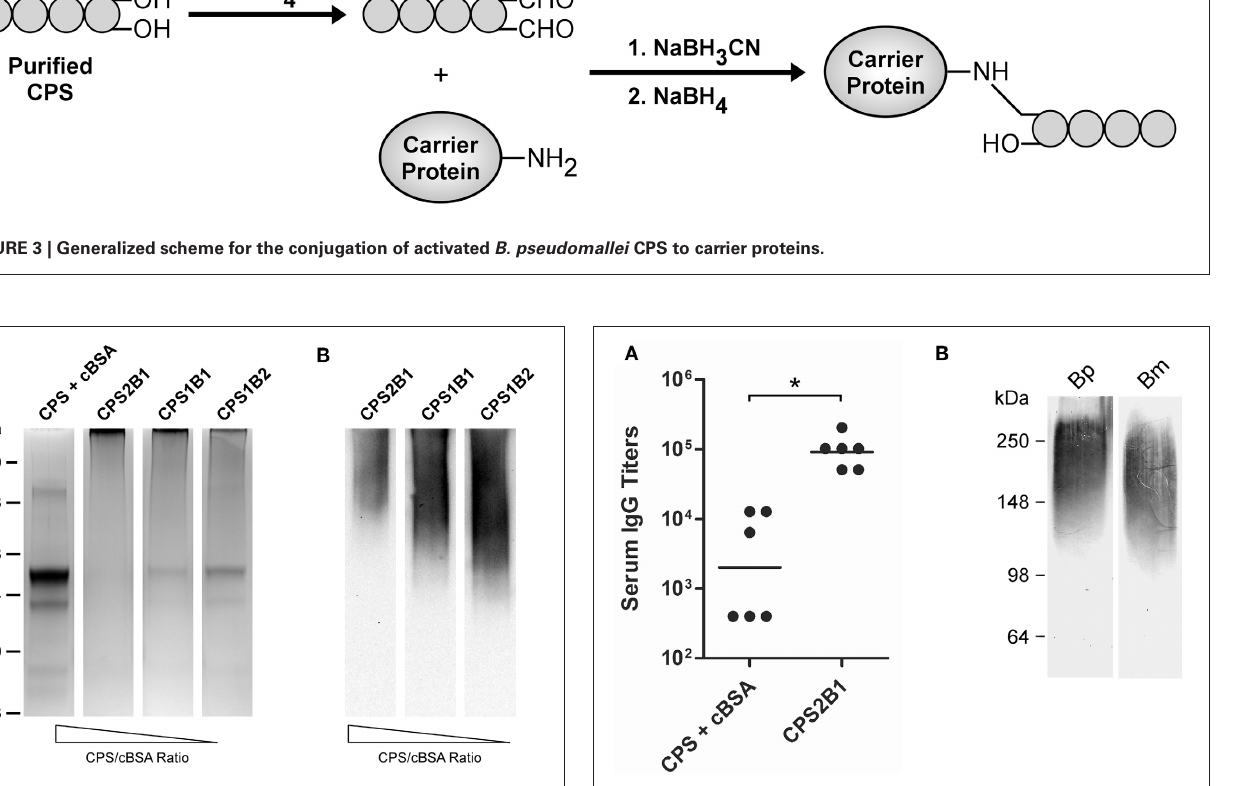
FIGURE 4 | Physical analysis of B. pseudomallei CPS-cBSA glycoconjugates. (A) SDS-PAGE and Coomassie Blue staining was used to confirm the covalent linkage of BP2683 CPS to cBSA. The positions of protein molecular size standards are indicated on the left. (B) Western immunobloting was also used to assess the antigenicity of the chemically activated/coupled BP2683 CPS. The CPS + cBSA lane represents unconjugated controls. CPS was detected using the 3C5 mAb. Lanes were loaded with similar amounts of protein or carbohydrate to facilitate direct comparisons.